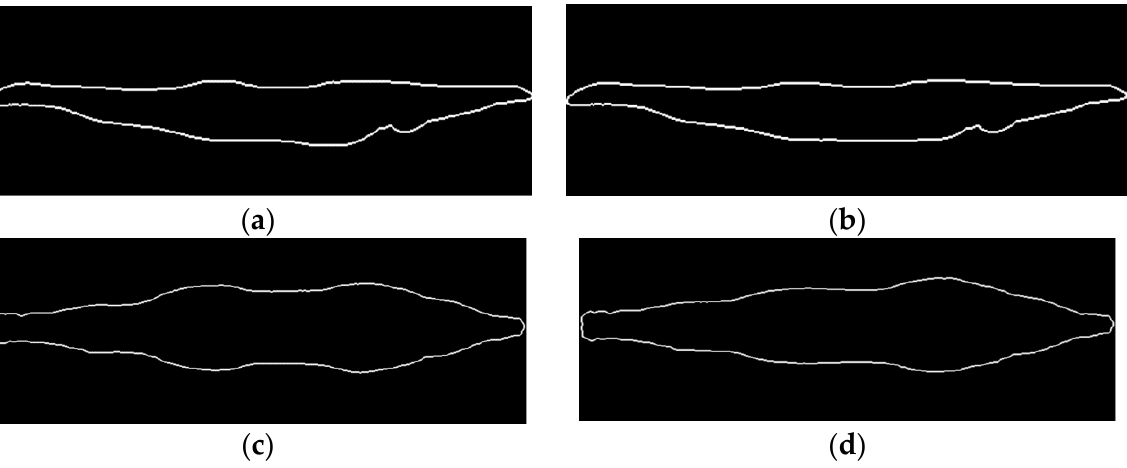
Figure 3. ( a ) Female Side View Contour; ( b ) Male Side View Model Contour; ( c ) Female Top View; ( d ) Male Top View